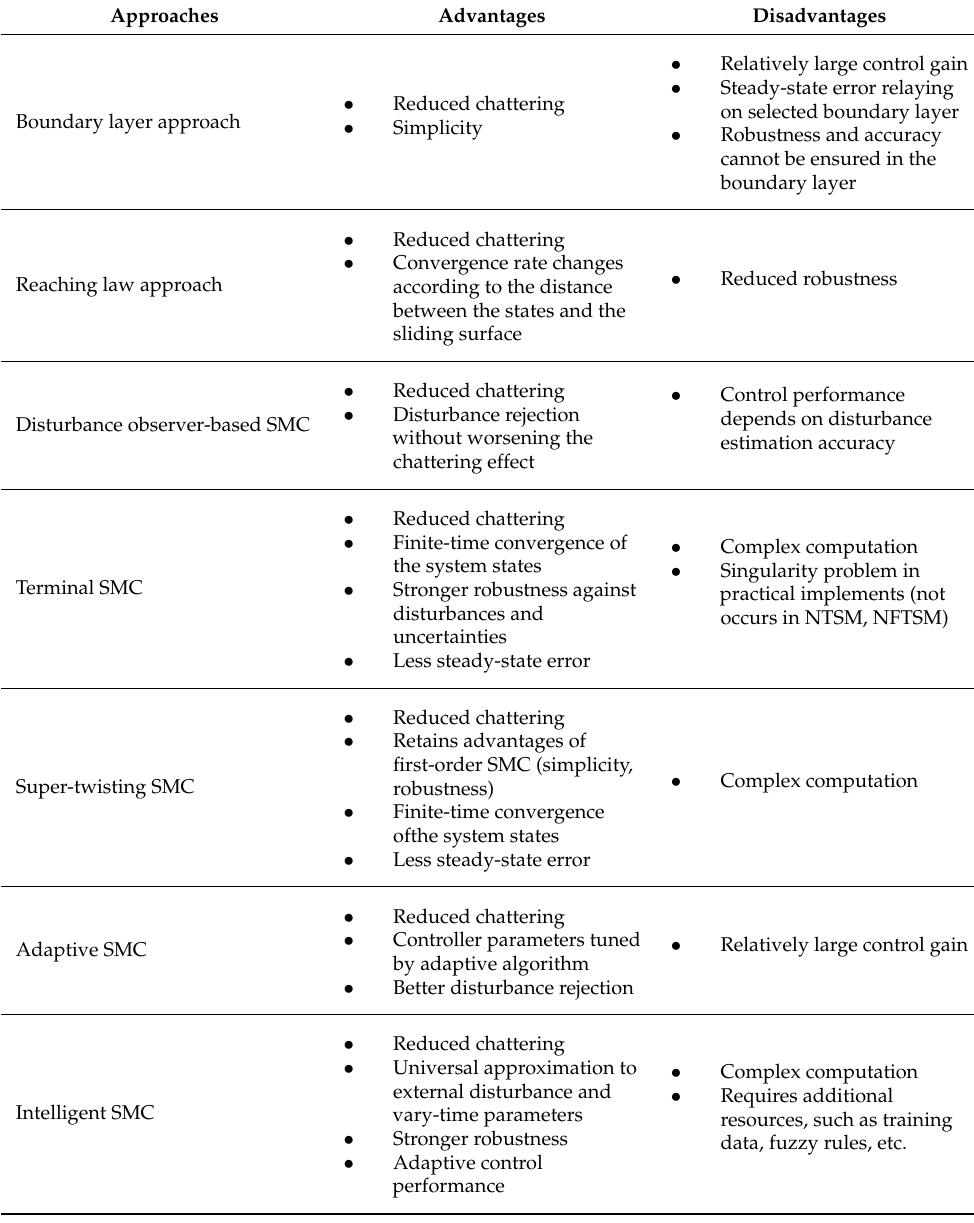
Table 2. Comparative discussion of the reviewed SMC for position/velocity control of